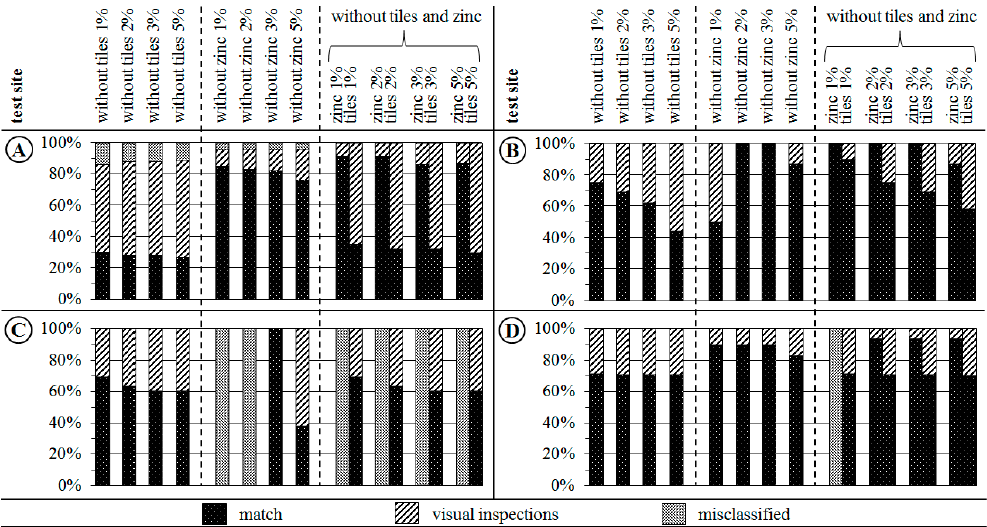
Figure 8. Percentage of spatial agreement by validating all pixels of an unknown material class (columns) detected for different library setups in the four test sites ( A – D ). Validation results are composed of a spatial match (black) of unknown pixels with validation pixels of material classes zinc or dark roofing tiles, visual inspections (hatched) by visual comparisons of mean spectra due to missing validation data, and (grey) misclassifications or missing data for an unknown material class.